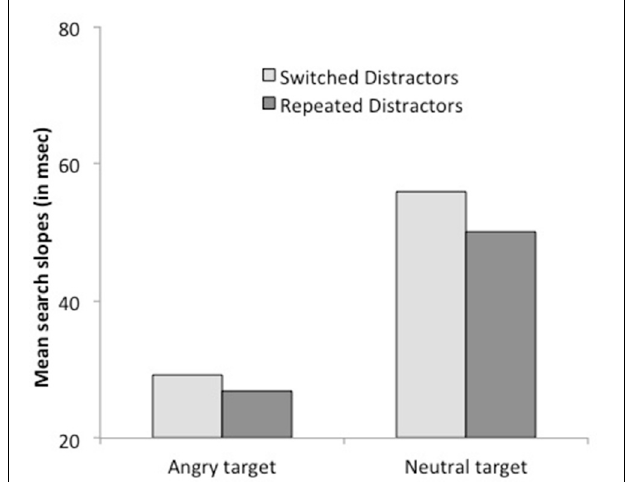
each added distractor) on target-present trials preceded by a target-present trial as a function of target emotion (angry or neutral) and target repetition (repeated or switched) in Experiment